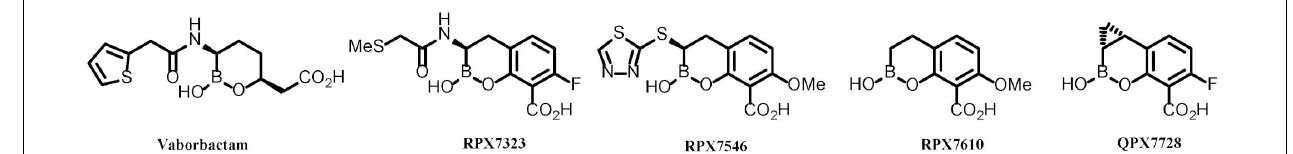
FIGURE 1 | Evolution of boronic β -lactamase inhibitors.